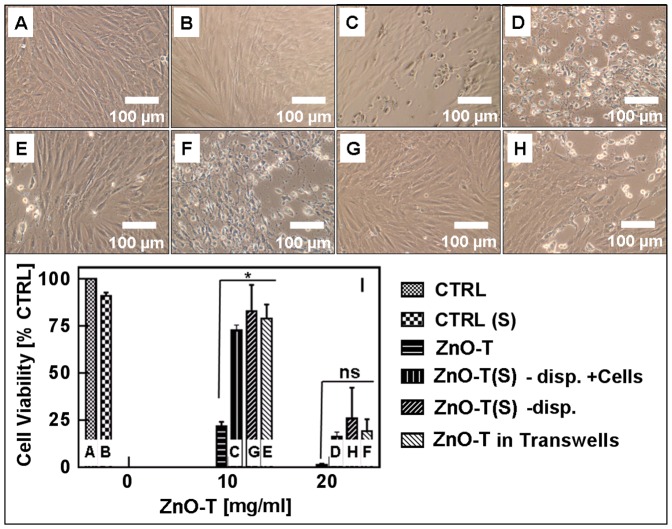
Role of direct cell contact for ZnO-T toxicity shown by phase contrast microscopy and changes in cell viability (MTT-Assay).Column diagram shows the cytotoxicological effects of different probes on normal human dermal fibroblasts (NHDF). CTRL (Image: A) = cell culture medium as control; CTRL (S) (Image: B) = supernatant of cell culture medium 24 h pre-incubated on NHDF as control; ZnO-T = ZnO-T in dispersion directly on NHDF (10 mg/ml or 20 mg/ml (Images: not shown due to overlapping of ZnO tetrapods layer)); ZnO-T (S) – disp. + cells = supernatant of ZnO-T in culture medium pre-incubated on NHDF for 24 h (10 mg/ml (Image: C) or 20 mg/ml (Image: D)); ZnO-T (S) – disp. = supernatant of ZnO-T in culture medium pre-incubated for 24 h without NHDF (10 mg/ml (Image: G) or 20 mg/ml (Image H); ZnO-T in Transwells = ZnO-T in dispersion (10 mg/ml (Image: E) or 20 mg/ml (Image: F) into transwells to prevent cell contact. Each value shown is the mean of three independent experiments (± SE). Passage number: P12–P14. Seeded cell number: 50000 cells/cm2; time prior treatment: 48 h; duration of treatment: 24 h. Each column represent the mean ± SE of n = 3 independent experiments. Statistical significance determined by one way analysis of variance: ZnO-T vs. C/D, G/H and E/F (* = p<0.05, ns = not significant).